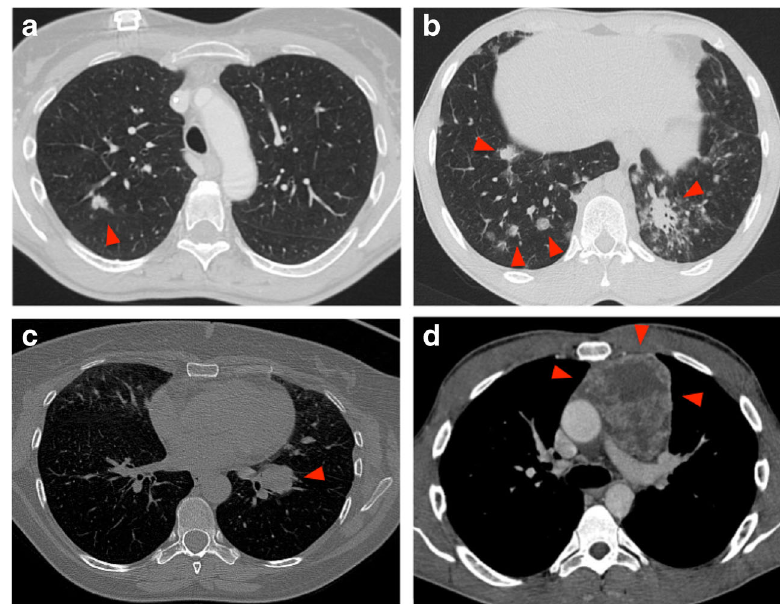
Fig. 1 Indications for CT-guided chest biopsy. (a) Solitary pulmonary nodule. (b) Parenchymal infiltrates in which